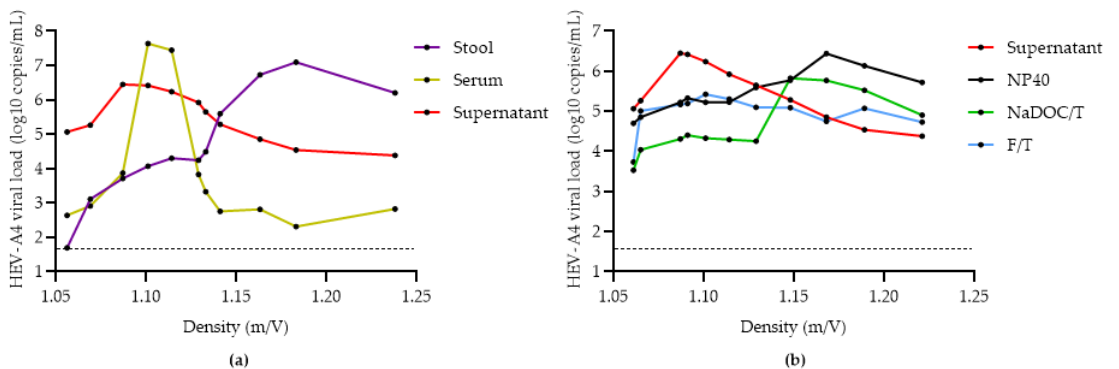
Figure 7. Ultracentrifuged iodixanol density gradient of ( a ) stool filtrate, serum, and untreated cell culture supernatant infected with HEV-A genotype 4 (HEV-A4); ( b ) HEV-A4-infected cell culture supernatant treated with NP-40, NaDOC/T, freeze–thaw cycle, and no treatment. Limit of detection of the RT-qPCR assay is represented by the dashed line (50 copies per mL for HEV-A4). This experiment could not be repeated with HEV-C1 due to low viral